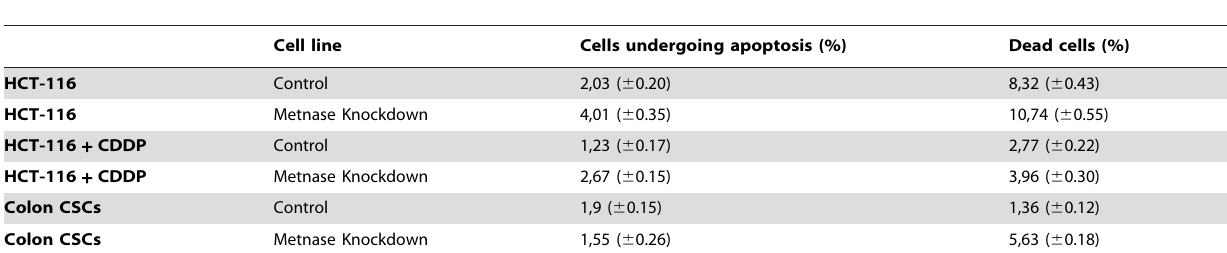
Table 2. Percentage of dead cells and cells undergoing apoptosis before and after Metnase